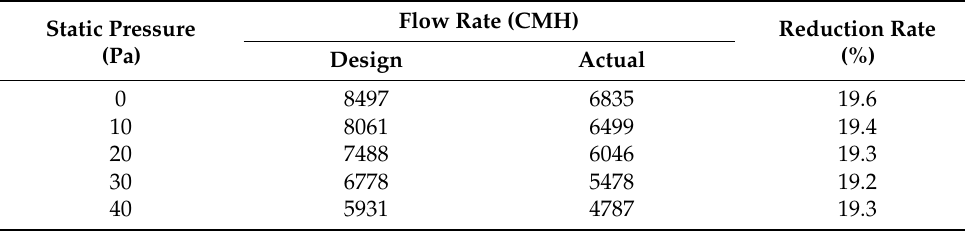
Table 1. Results from measuring the ventilation rate of exhaust fan in the experimental pig house .